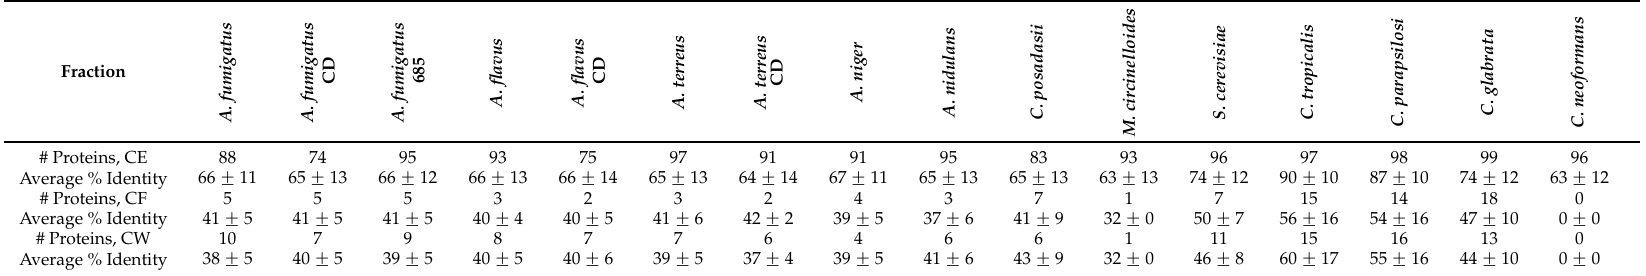
Table 3. Homology comparisons for the 100 most abundant CE proteins and all SSL proteins of Candida albicans